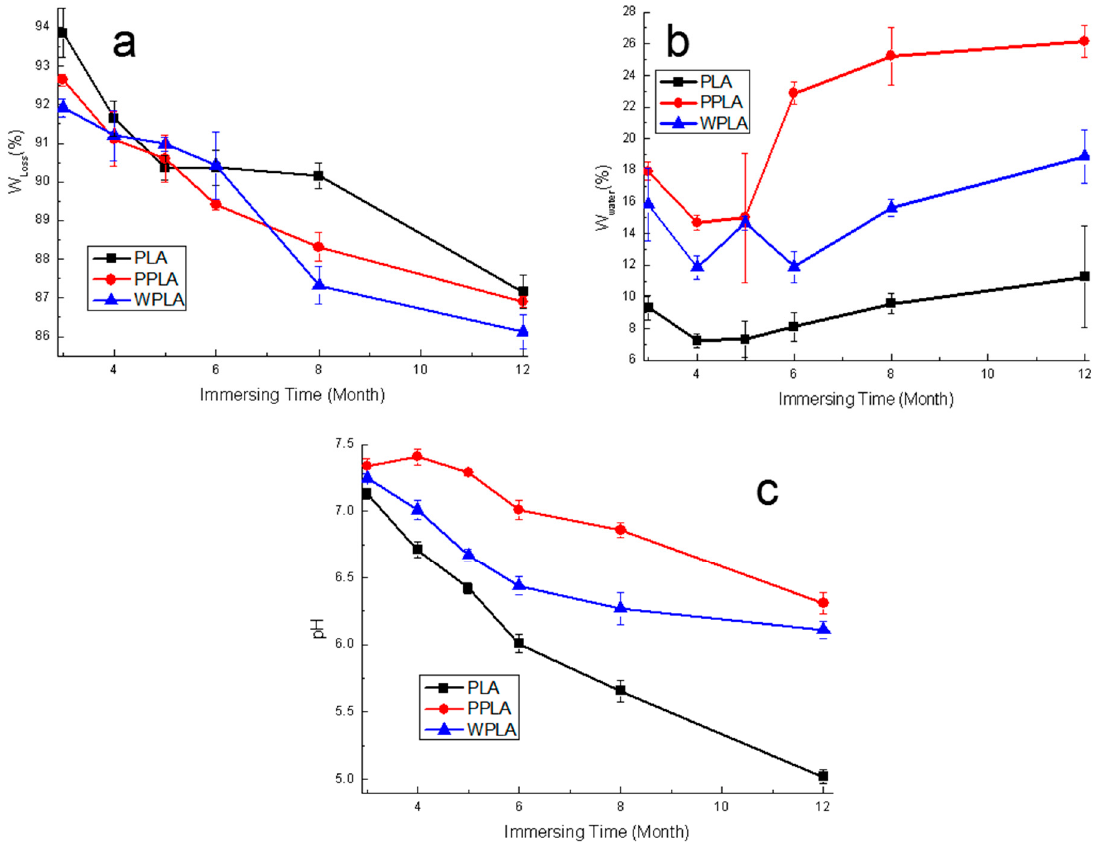
Figure 3. The ( a ) weight loss, ( b ) water intake and ( c ) pH value as a function of the degradation time of the neat PLA and composite immersed in the phosphate buffer solution